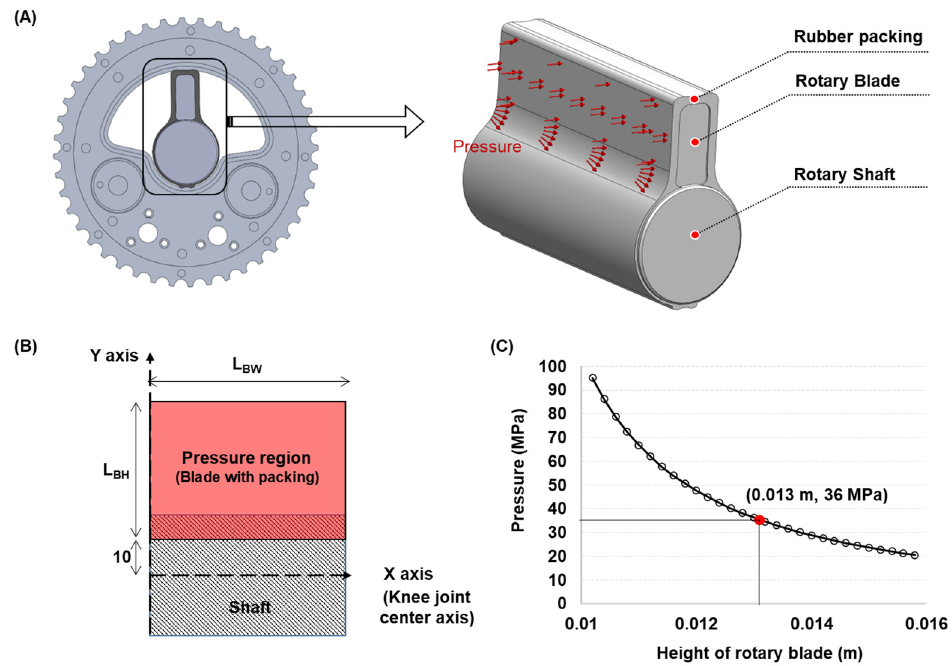
Figure 3. Design of rotary blade: ( A ) pressure distribution shape of a rotary blade; ( B ) area where pressure is applied to a rotary blade; ( C ) pressure graph generated according to changes in the height of rotary blade (red dot: optimal shape design poi).